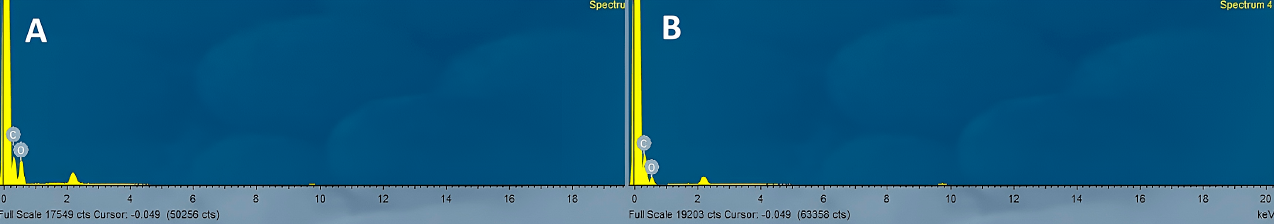
Figure 5. EDX analysis of untreated cotton ( A ) and graphite-based cotton ( B ).